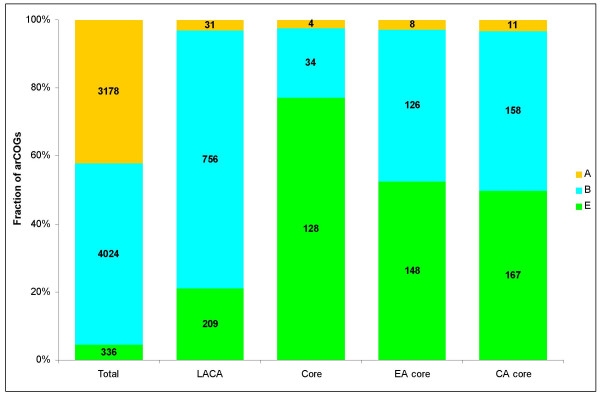
Taxonomic affinities of ArCOGs with bacteria and eukaryotes. For the criteria of taxonomic assignments, see Materials and Methods.A, archaea, B, bacteria, E, eukaryotes.